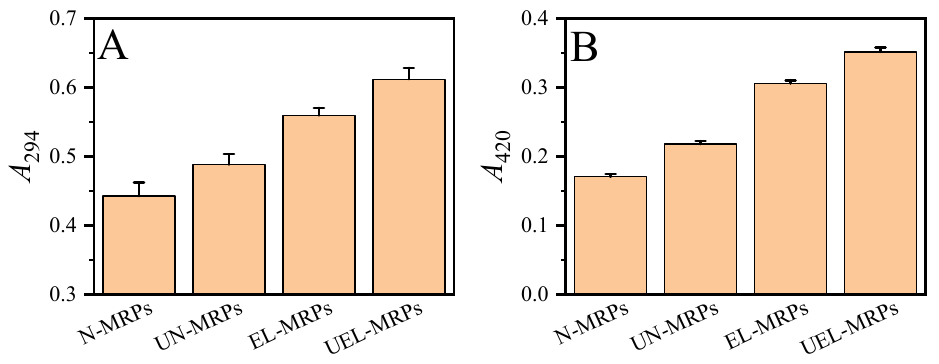
Figure 1. The UV–Vis absorbance at 294 nm ( A ) and 420 nm ( B ).